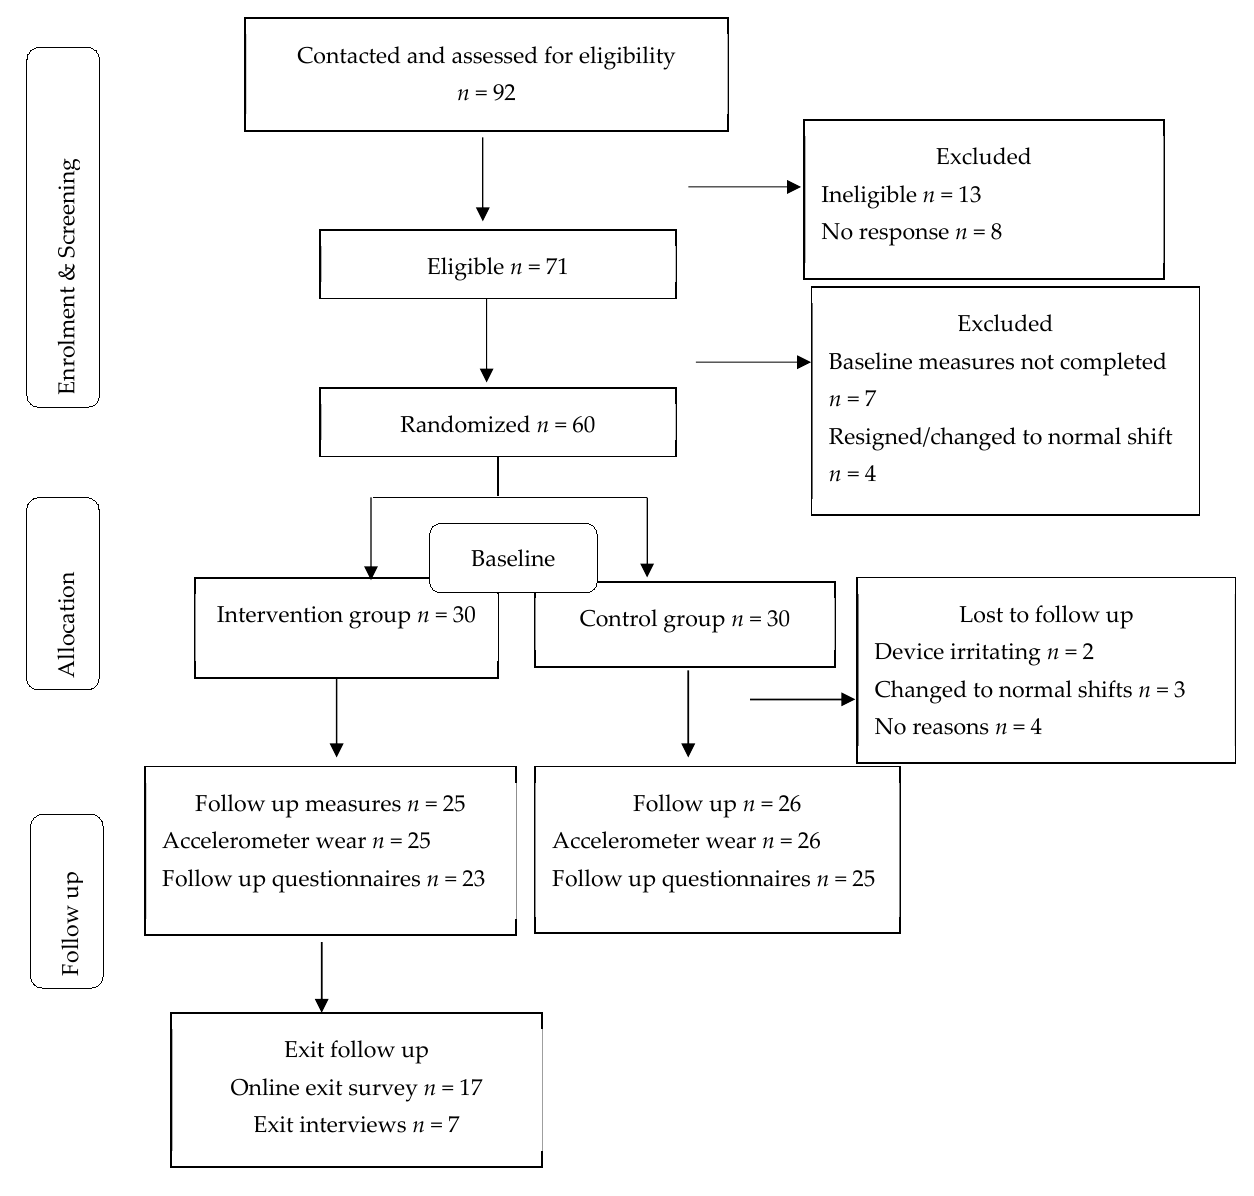
Figure 1. Flow chart of participants.